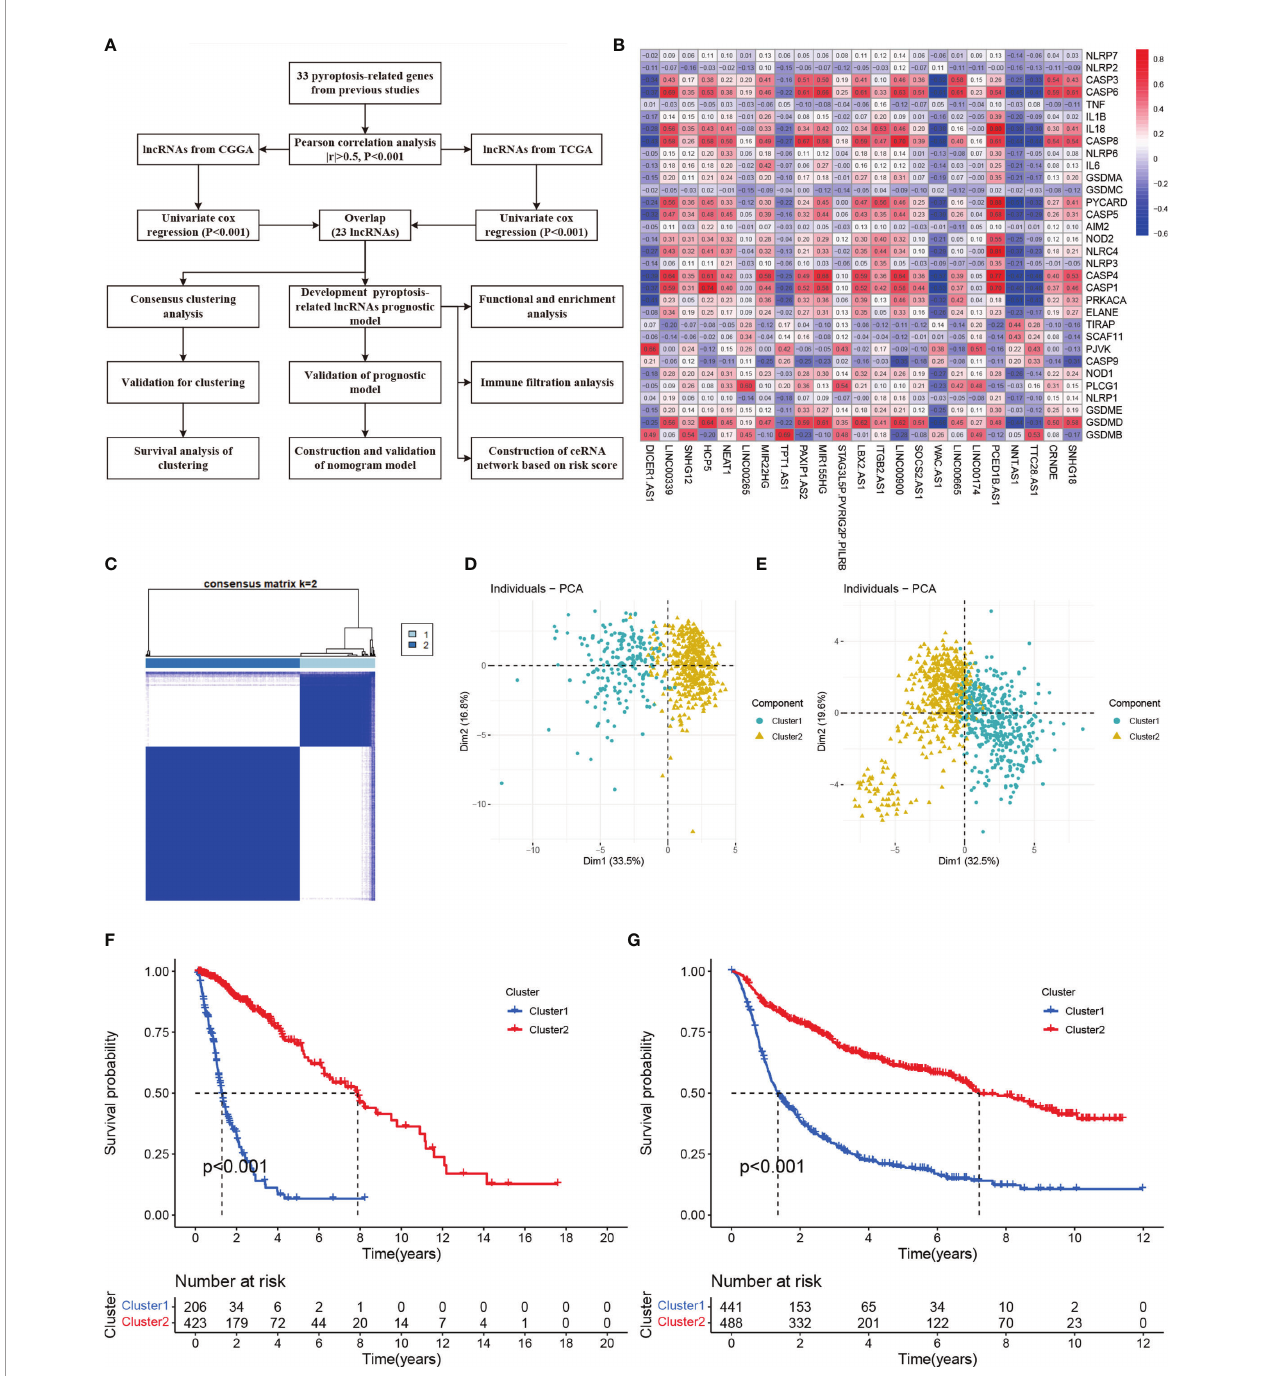
FIGURE 1 | Molecular classi fi cation based on differential expressed genes. (A) A fl ow chart of study (B) Heatmap showed the correlation of 33 pyroptosis-related with 23 lncRNAs. (C) Glioma patients were divided into two clusters in TCGA. (D) PCA indicated that two subclasses were obtained in TCGA. (E) Two subclasses were validated in CGGA. (F) Overall survival cure of two clusters in TCGA. (G) Overall survival cure of two clusters in